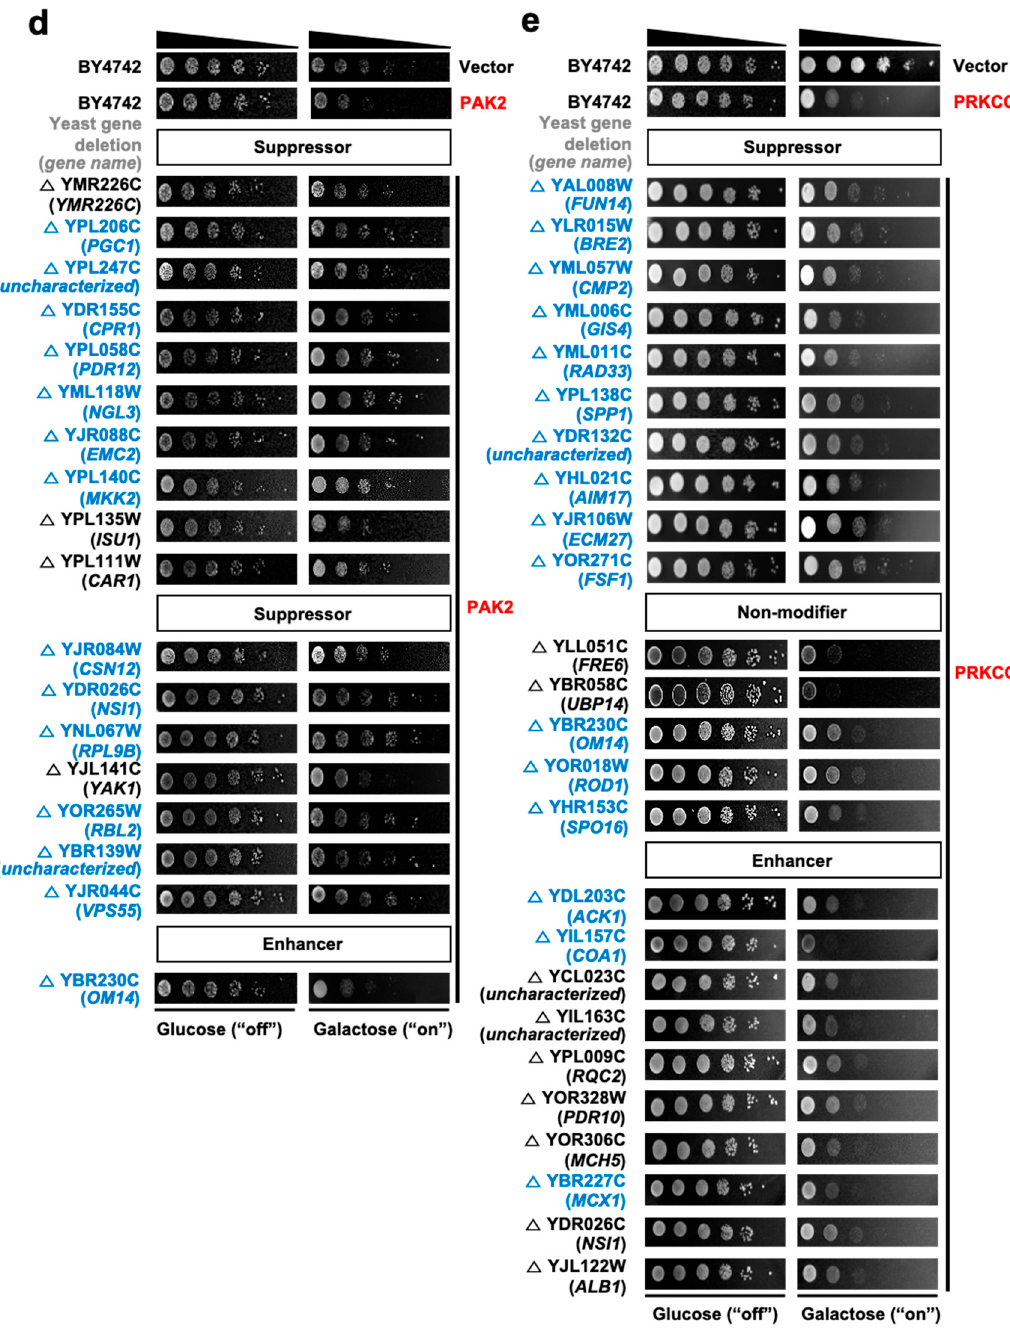
Figure 3. Validation of toxicity modifiers by yeast spotting assays. From the Bar-seq data analysis and Z-score distributions, three groups of yeast genes were chosen for spotting assays: group 1, toxicity suppressors; group 2, non-modifiers; and group 3, toxicity enhancers. Toxicity modifiers for five kinases (IKBKE, MAPK9, PAK1, PAK2 and PRKCQ) were tested by yeast spotting assays. ( a ) Suppressors, non-modifiers and enhancers for IKBKE; ( b ) suppressors and non-modifiers for MAPK9; ( c ) suppressors for PAK1; ( d ) suppressors and enhancers for PAK2; ( e ) suppressors, non-modifiers and enhancers for PRKCQ. For each kinase, 10 suppressors, 5 non-modifiers and 10 enhancers were tested. If the total number of toxicity modifiers was less than 5 for non-modifiers or 10 for enhancers, all modifiers were tested. For PAK1 and PAK2, additional suppressors were tested. Deletion strains in blue indicate consistent results between Bar-seq-based genetic interactions and individual spotting assays. pAG425GAL-ccdB was used as the empty vector control. BY4742 is the wild-type yeast strain.